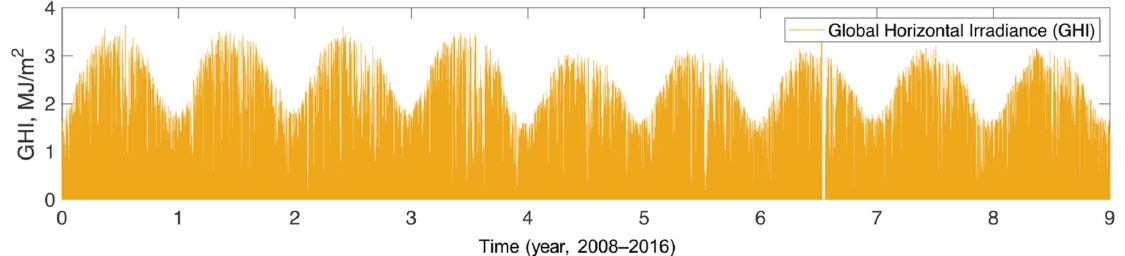
Figure 5. Historical data for 9 years (2008–2016): Global Horizontal Irradiance (GHI).